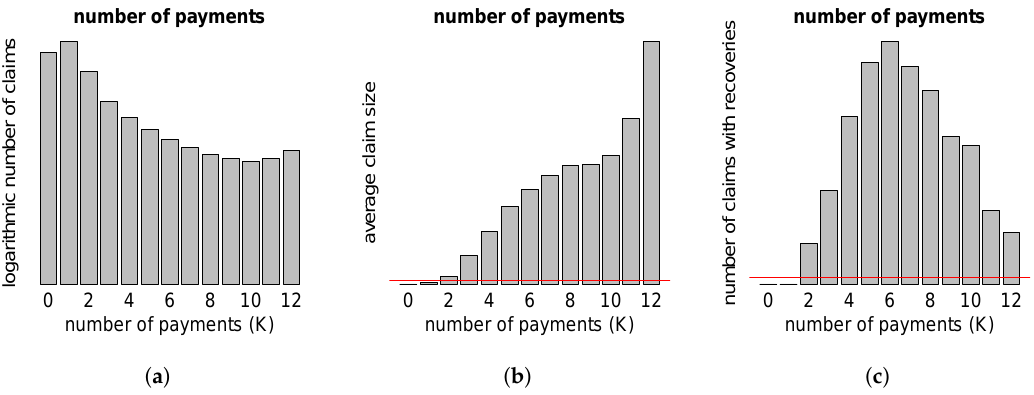
Figure A3. ( a ) Logarithmic number of claims; ( b ) average claim size and ( c ) number of claims with recoveries w.r.t. the number of payments K ; the red lines show the averages.